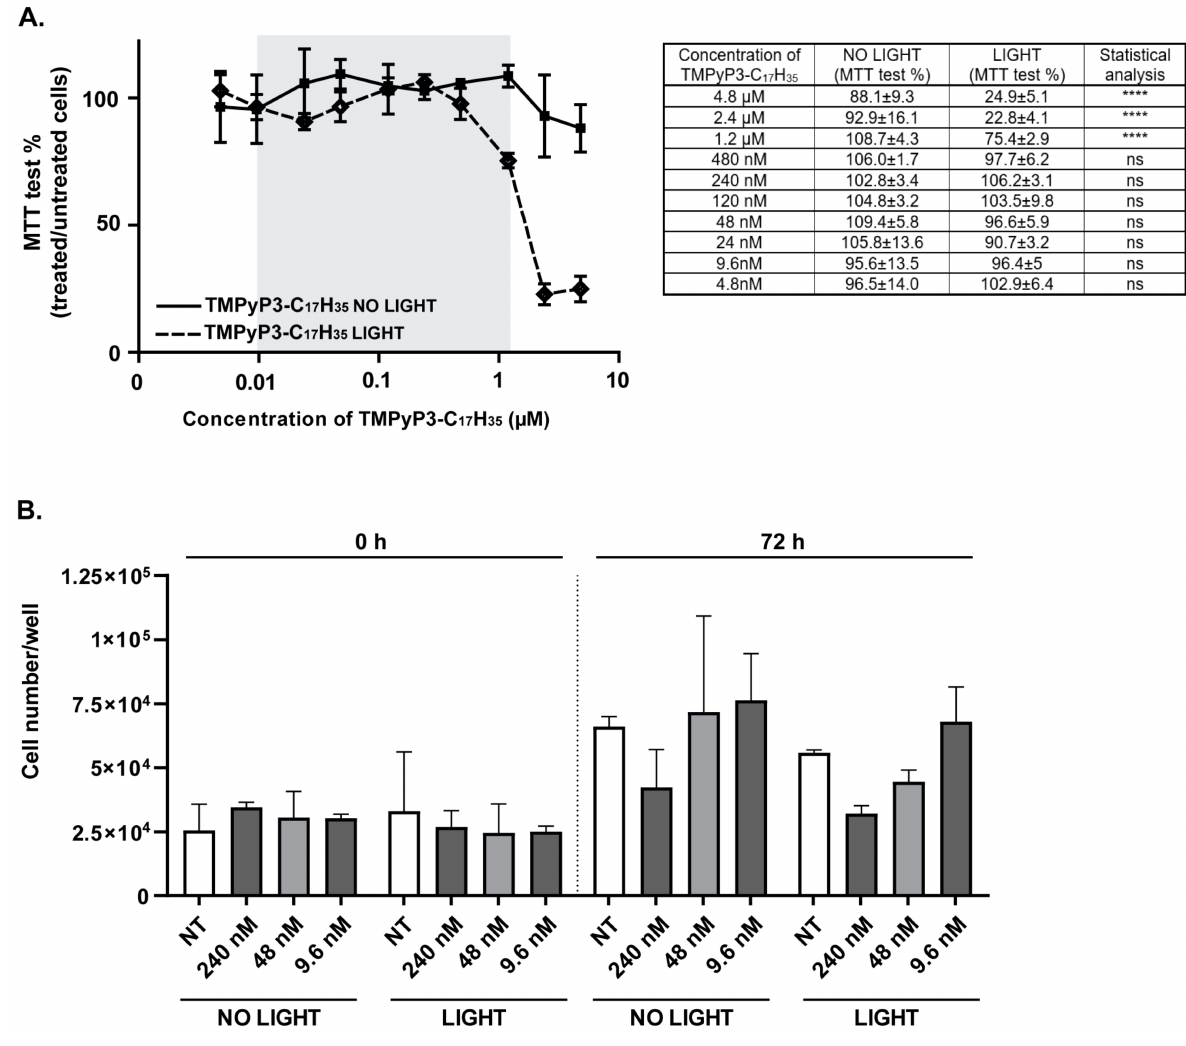
Figure 3. Cytotoxicity of TMPyP3-C 17 H 35 . ( A ) Vero cells were treated with a wide range of concentra- tions of TMPyP3-C 17 H 35 (4.8 nM–4.8 µ M). One set of the plates was irradiated with low-fluency